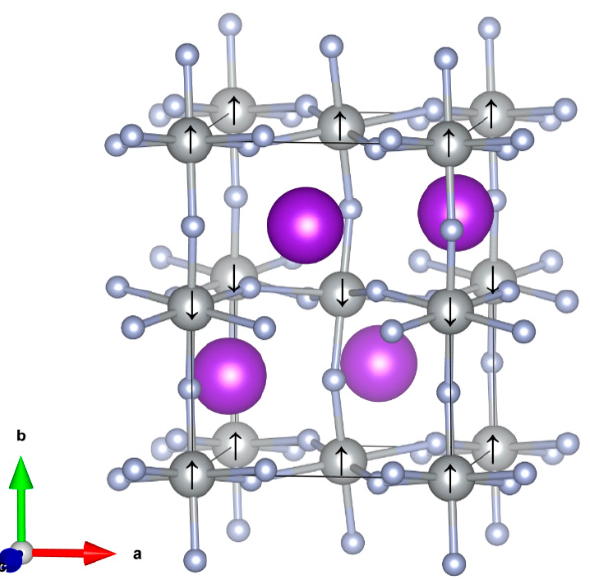
Figure 1. Ground state spin ordering in KAgF 3 P nma structure as marked by black arrow (gray—Ag; light blue—F; violet—K).